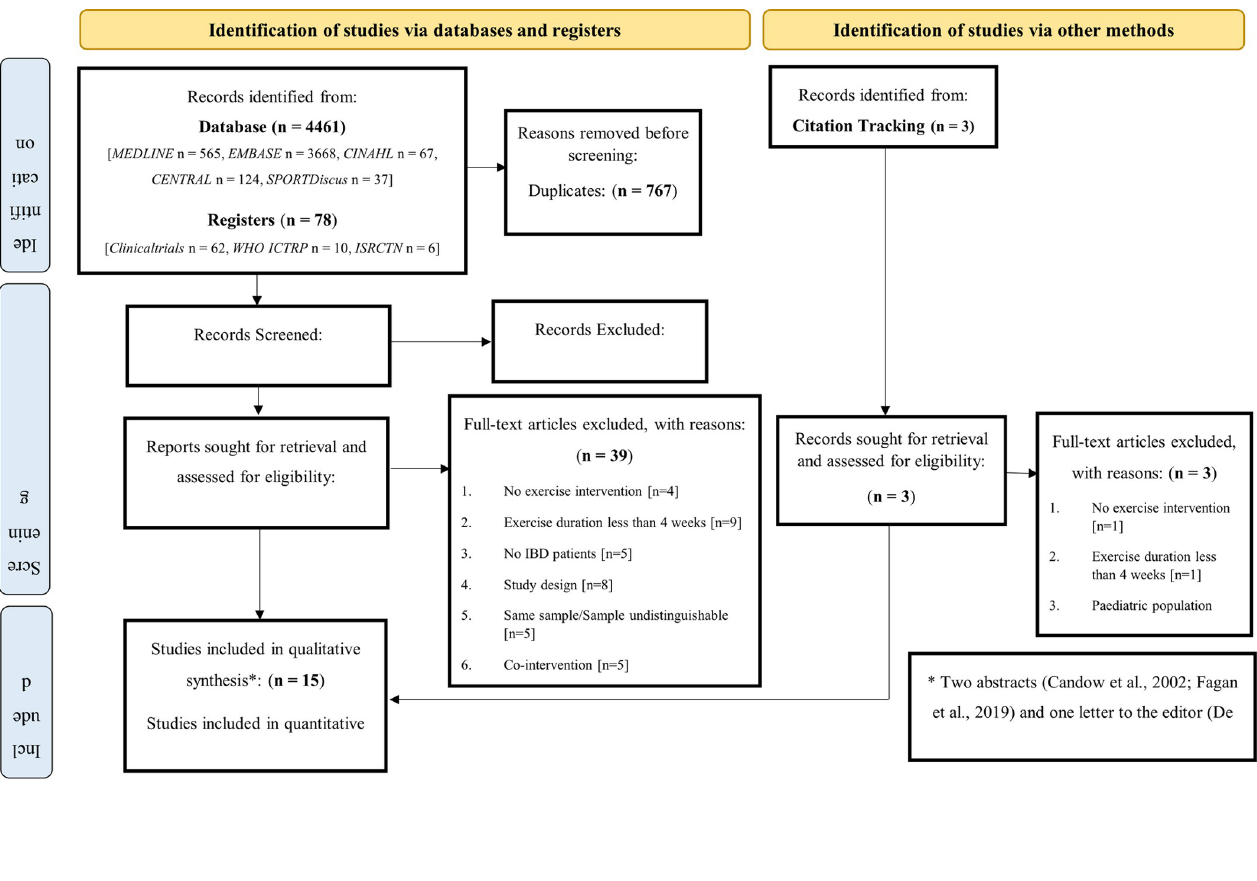
Fig 1. PRISMA flow diagram of literature search and study selection phases. n, number; CENTRAL, Cochrane Central Register of Controlled Trials; WHO ICTRP, World Health Organisation International Clinical Trials Registry Platform.